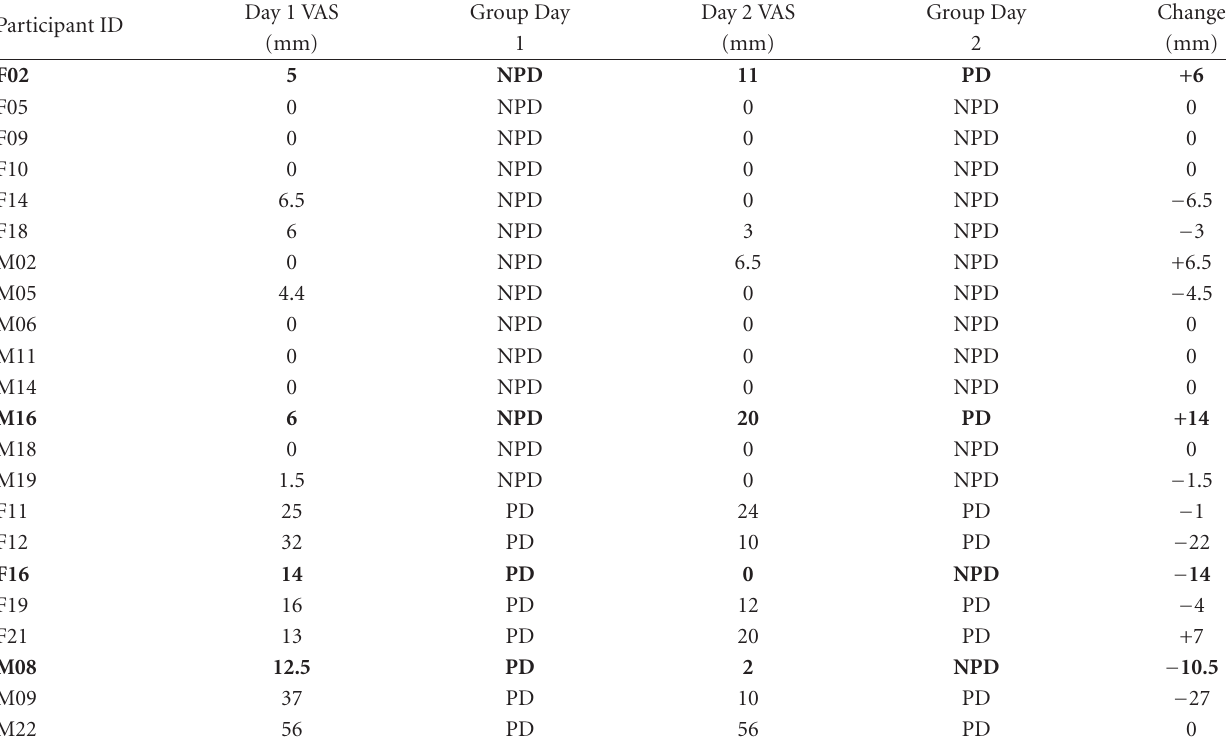
Table 3: Low back Visual Analog Scale (VAS) scores for Days 1 and 2. Participants who changed groups are in bold.